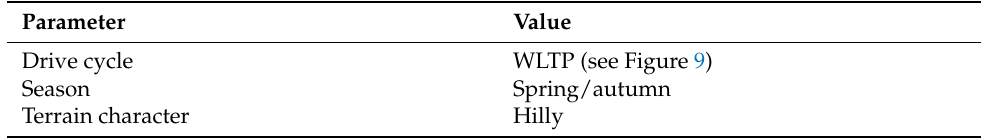
Table 13. Scenario parameters and their possible values used in current simulations.